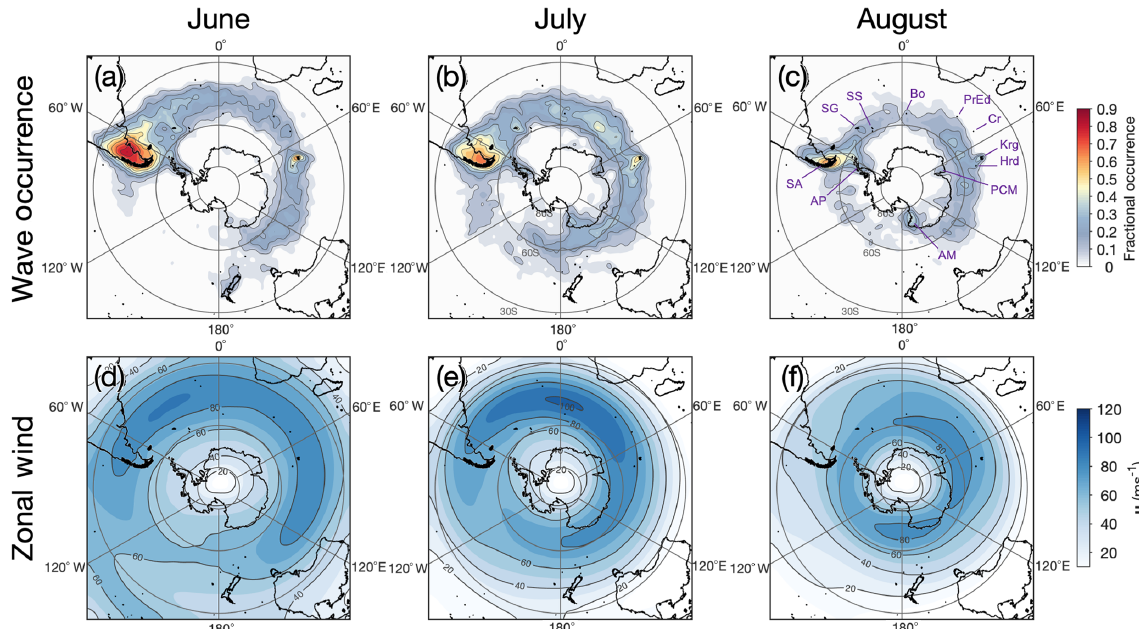
Figure 6. Monthly gravity wave occurrence frequency at z = 40km over the Southern Hemisphere for June, July and August 2010 (a–c) . Wave occurrence is defined here as the fraction of AIRS pixels with 3DST-measured absolute wave amplitude above a noise threshold of 1.5K. Panels (d–f) show monthly mean zonal wind at z = 40km from ERA5 reanalysis for the same time period. For reference in later sections, the locations of the southern Andes (SA), Antarctic Peninsula (AP), South Georgia (SG), and the South Sandwich (SS), Bouvet (Bo), Prince Edward (PrEd), Crozet (Cr), Kerguelen (Krg) and Heard (Hrd) islands are marked in panel (c), along with the locations of the Prince Charles (PCM) and Admiralty (AM) mountains on the continent of